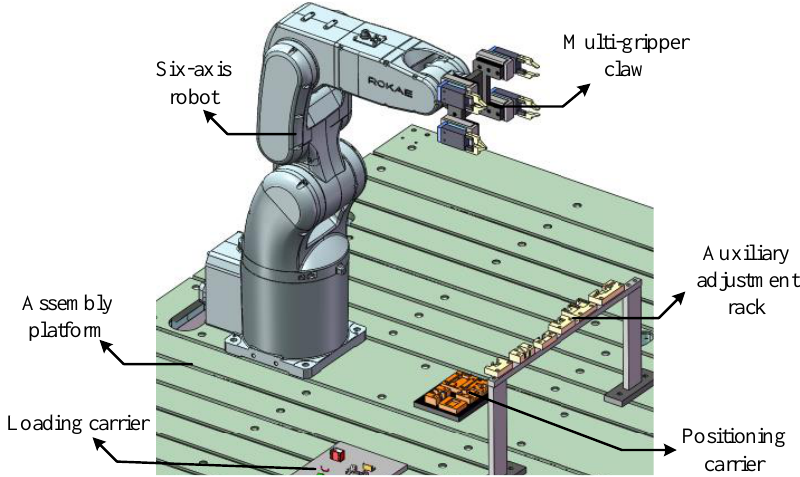
Figure 3. Posture adjustment platform.